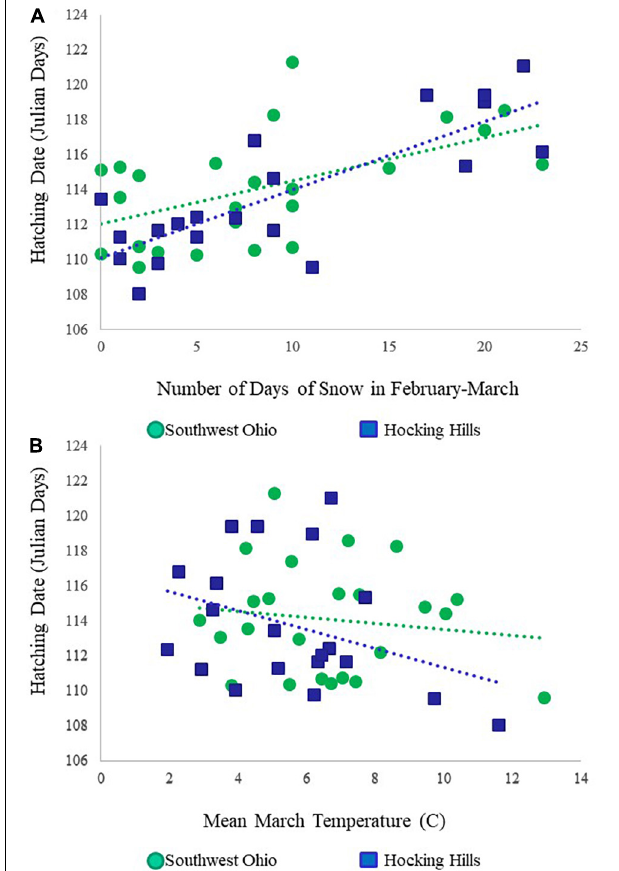
FIGURE 1 | (A) Relationship between mean hatching date and number of days of snow cover in February–March, and (B) relationship between mean hatching date and mean March temperature for Red-shouldered Hawks in southwest Ohio and Hocking Hills study areas in southern Ohio, United States.